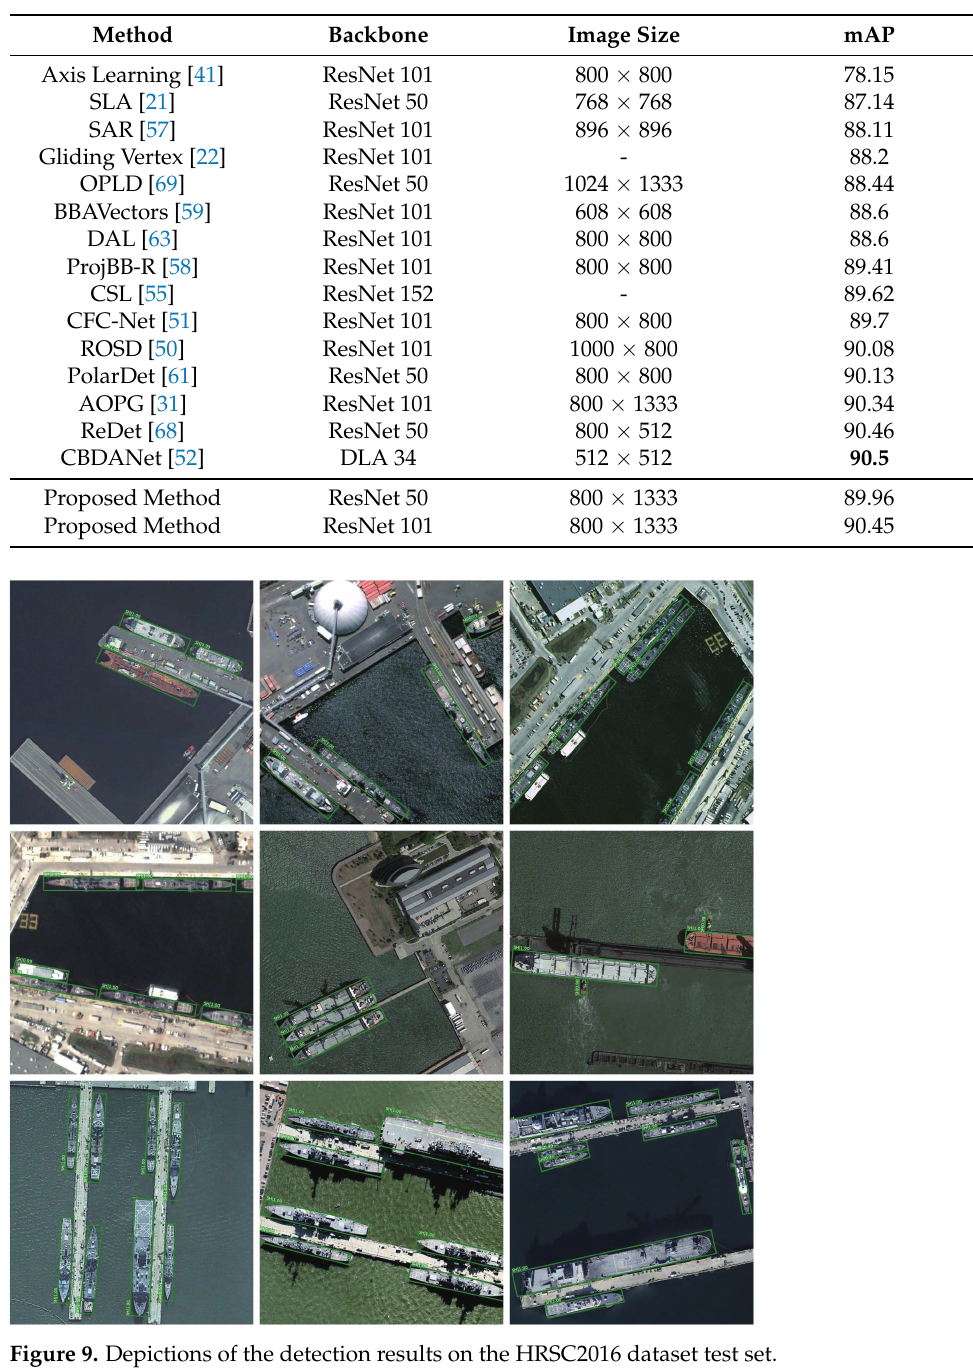
Figure 9. Depictions of the detection results on the HRSC2016 dataset test